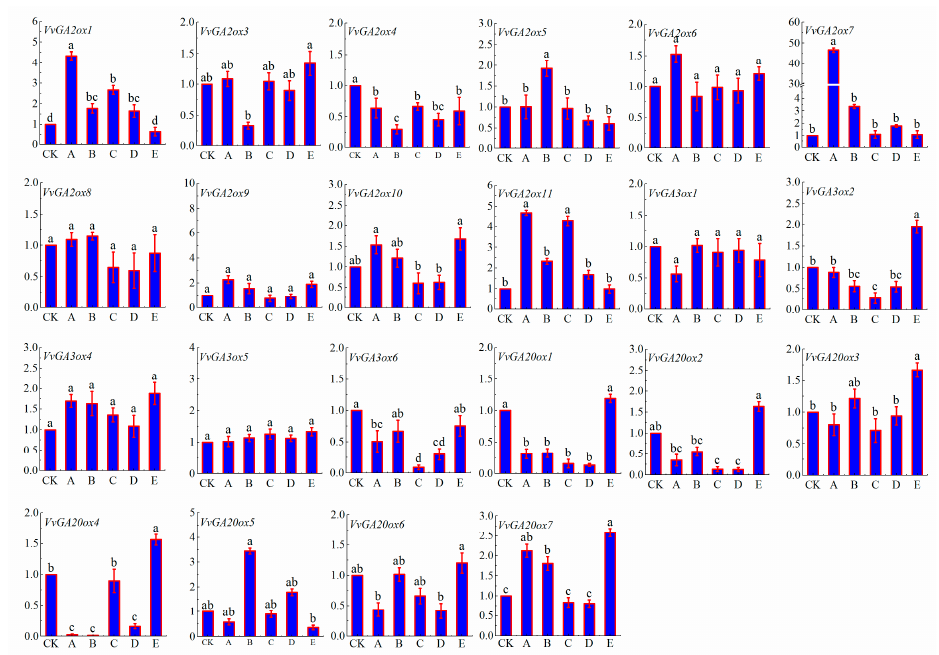
Figure 8. Expression levels of VvGA2ox, VvGA3ox, and VvGA20ox in grape leaves after 24 h under different treatments with CK, contrast check; A, 5 mg·L-1 gibberellin 3 (GA3) ; B, 10 mg·L-1 GA3 ; C, 15 mg·L-1 GA3 ; D, 20 mg·L-1 GA3 ; and E, 10 mg·L-1 uniconazole. The specimens were analyzed through real time PCR. GAPDH (CB973647) was detected as an internal reference gene. Gene expression was normalized to the control unstressed expression level, which was assigned with a value of 1. Data represented the average of three independent experiments ± SD. Standard errors were shown as bars above the columns. a, b, c denotes significant difference at the level of p < 0.05.